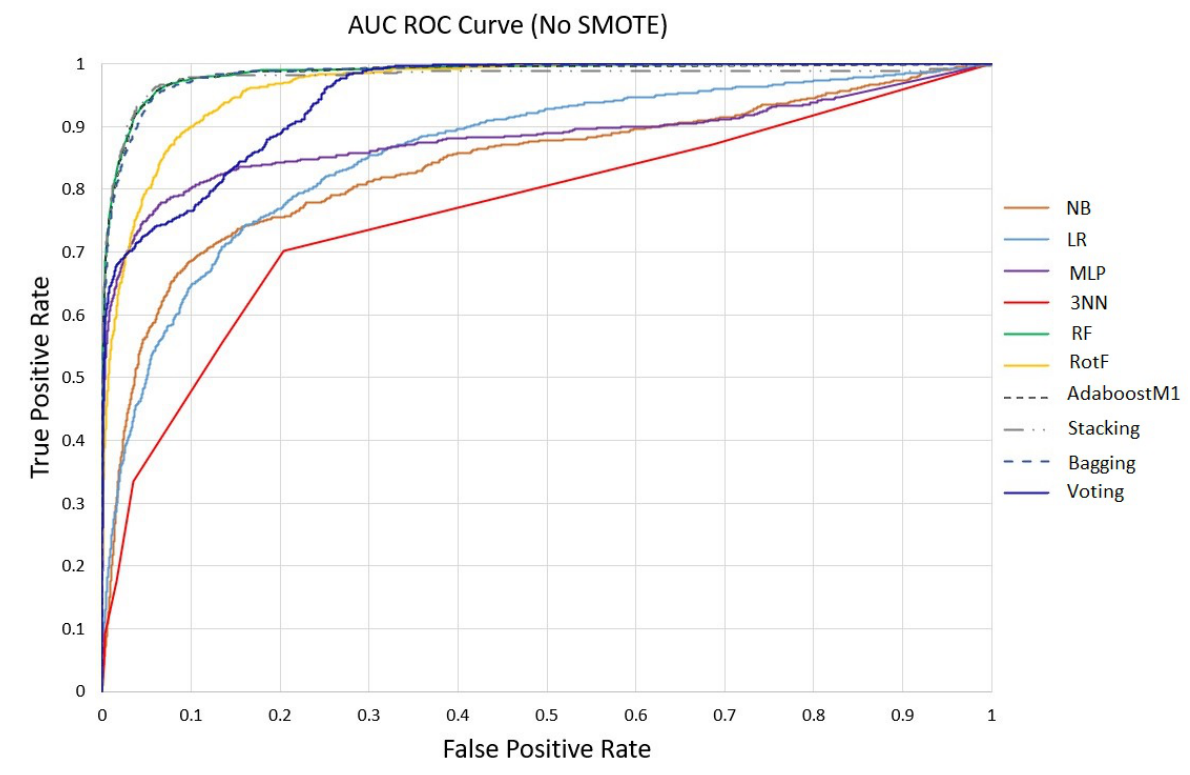
Figure 2. ML models AUC ROC vurve without